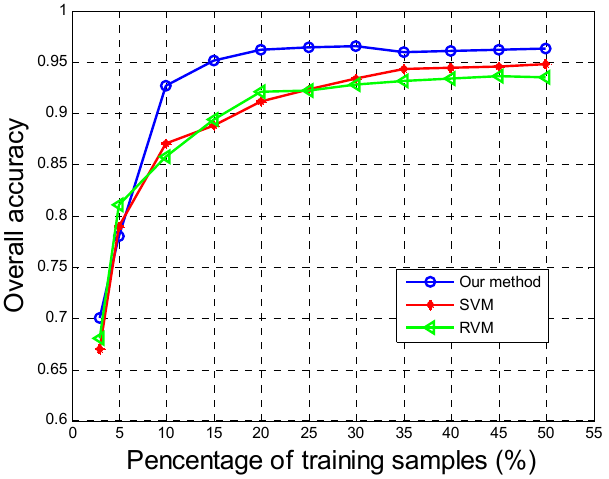
Figure 8. Effect of the number of training